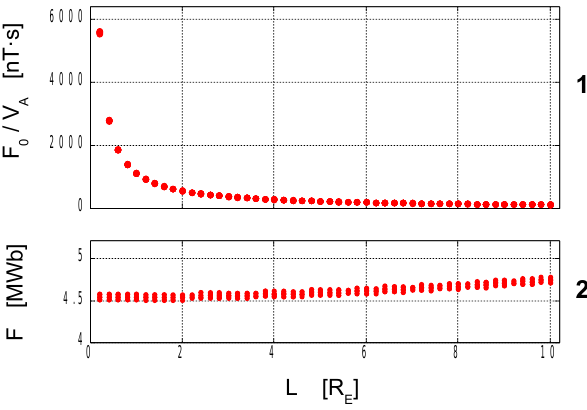
L [R ] E Fig. 7. Panel 1: Numerical solution for specific reconnected flux F 0 divided by Alfv´en velocity V A , depending on the length of the X -line, L . Panel 2: dependence between full reconnected flux F and L .